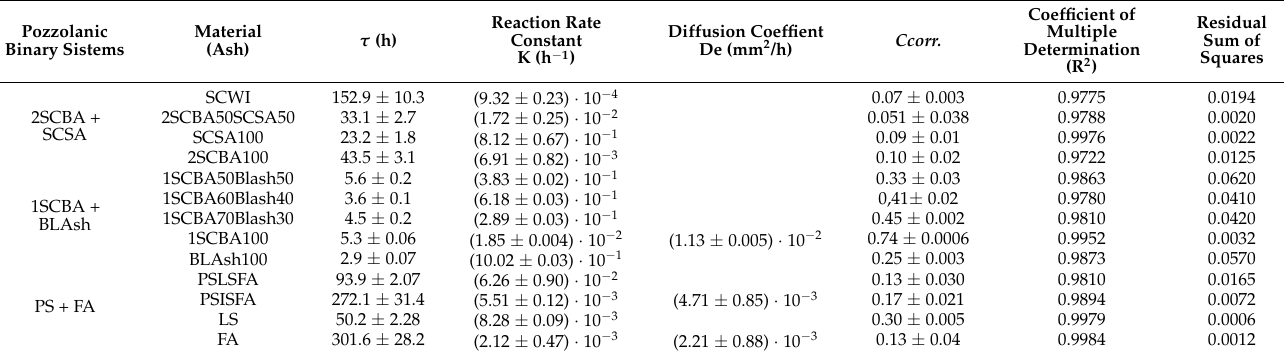
Table 3. Reaction rate constant K, τ parameter, C corr . parameter and statistical parameters for the pozzolanic materials. Pozzolanic Binary